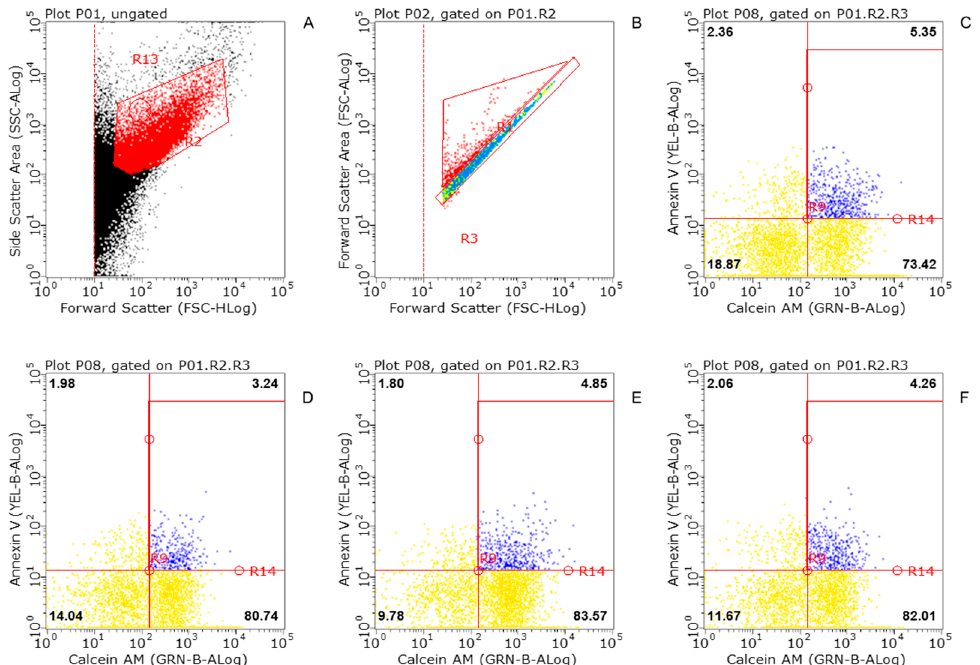
Figure 1. Flow cytometric analysis of striatal synaptosomes exposed to in or out KLVFF, or scramble peptide (VFLKF). ( A ) Representative density plot of synaptosomal preparation. ( B ) Singolet distri- bution of synaptosomal particles. ( C ) Calcein AM fluorescence versus Annexin V fluorescence for control synaptosomal particles. ( D ) Calcein AM fluorescence versus Annexin V fluorescence for KLVFF-treated synaptosomes (1 h). ( E ) Calcein AM fluorescence versus Annexin V fluorescence for VFLKF-treated synaptosomes (1 h). ( F ) Calcein AM fluorescence versus Annexin V fluorescence for KLVFF-entrapped synaptosomes. The percentage of total particles is shown for each quadrant. Particles positive for both markers are in the upper right